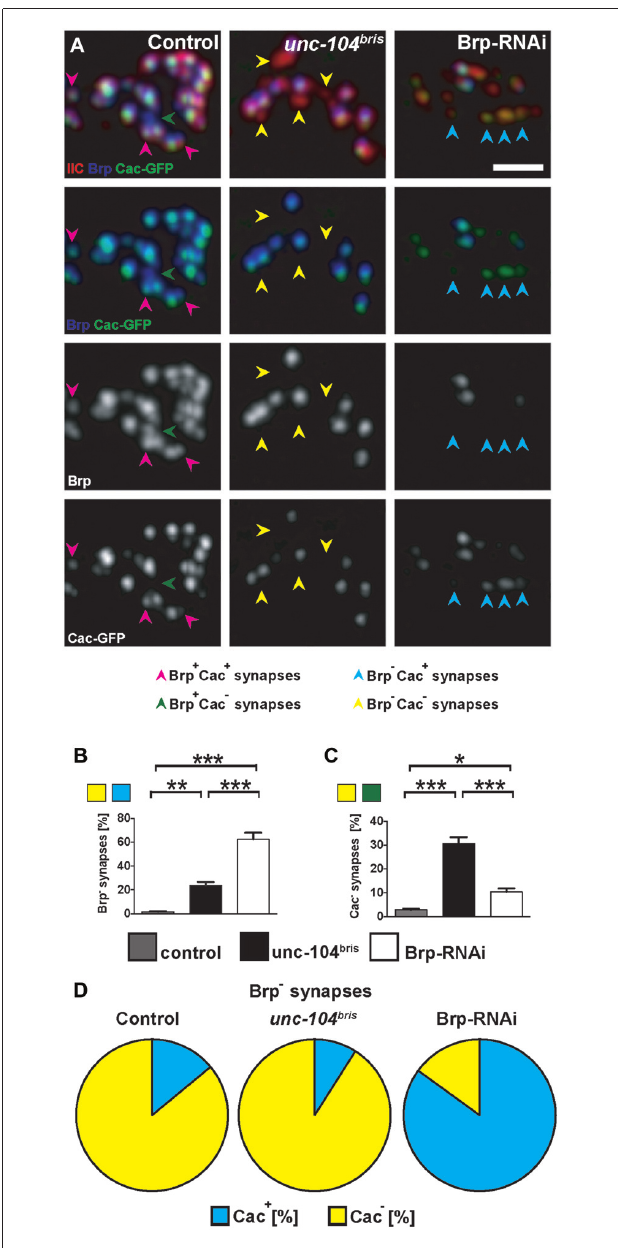
FIGURE 2 | Cacophony (Cac) at the NMJ of unc-104 bris mutant and Brp-RNAi expressing larvae. (A–C) Pattern of Cac clustering observed by expressing GFP-tagged Cac (Cac-GFP) at the active zones (AZs) in control, unc-104 bris and Brp-RNAi larvae (A) . Brp − synapses in unc-104 bris animals are also devoid of Cac-GFP (yellow arrowheads). In contrast, Brp − synapses in Brp-RNAi animals are mostly Cac-GFP positive (blue arrowheads). (B,C) Quantifications of the percentages of Brp − and Cac-GFP negative (Cac − ) synapses. (D) Pie-charts showing the proportion of Brp − synapses that are Cac-GFP positive (Cac + ) and Cac − . Genotypes in (A) : control ( elavX-Gal4/+ ;; UAS-Cac-GFP/+ ), unc-104 bris ( elavX-Gal4/+ ;unc -104 bris /unc-104 d 11024 ; UAS-Cac-GFP/+ ), Brp-RNAi ( elavX-Gal4/+ ;; UAS-Brp-RNAi/UAS-Cac-GFP ). Experiments were performed at 29 ◦ C. Scale bar: 2 µ m. Statistical test: one-way ANOVA followed by Tukey’s Multiple Comparison Test. ∗ p < 0.05; ∗∗ p < 0.01; ∗∗∗ p < 0.001. Error bars represent